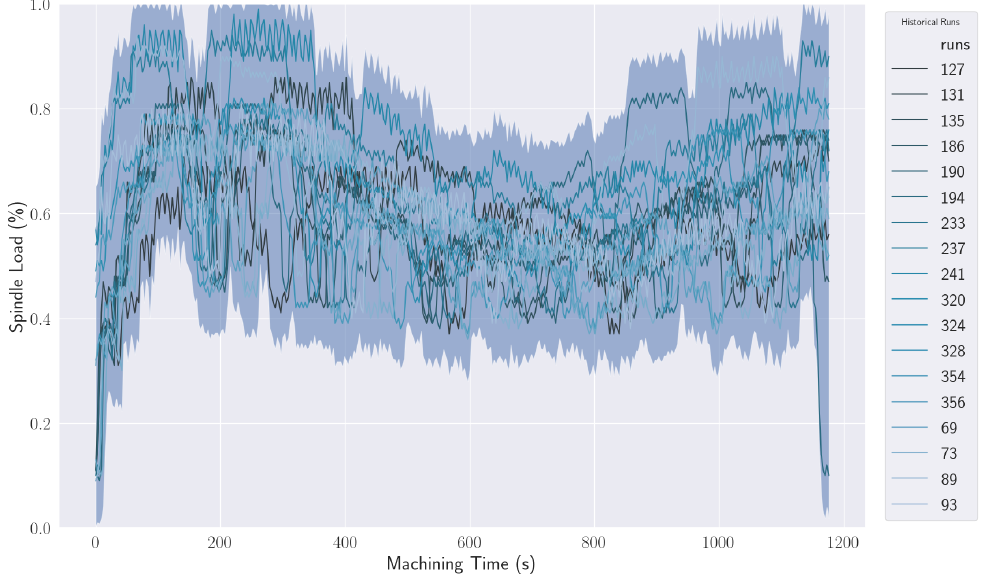
Figure 7. Program 1543 tool 6040 on machine T5-1 normal behavior